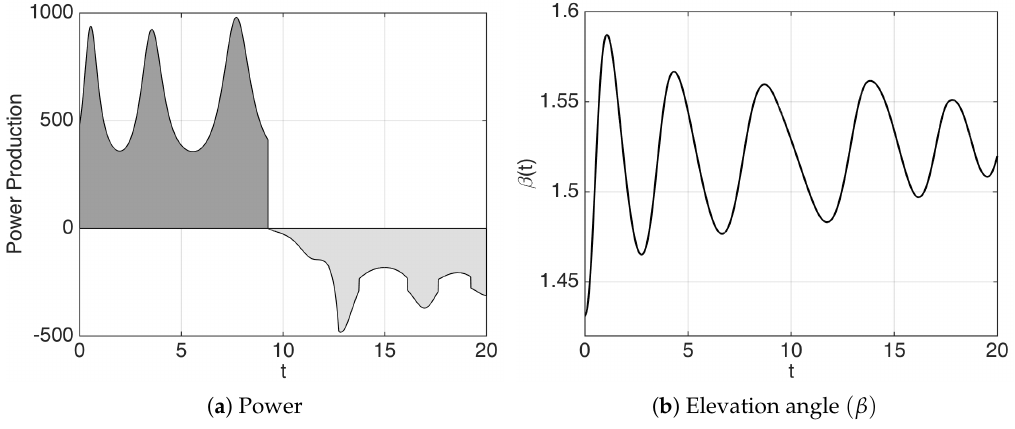
Figure 6. Power production and elevation angle for the 2D problem. Table 2. Efficiency comparison for each